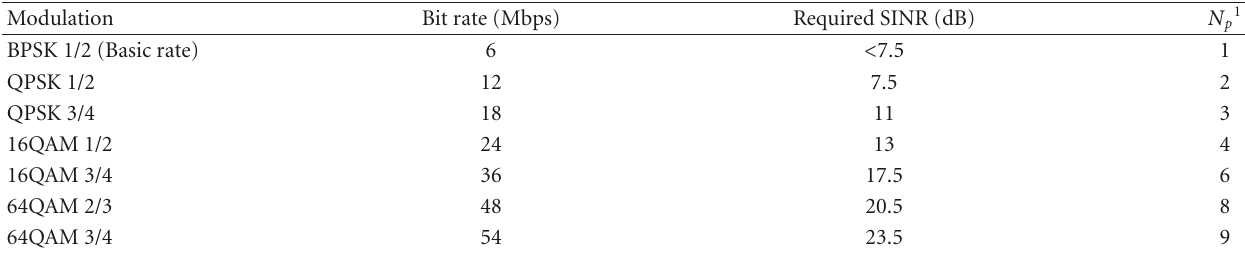
Table 3: Adaptive modulation table for required PER = 10 − 2 .